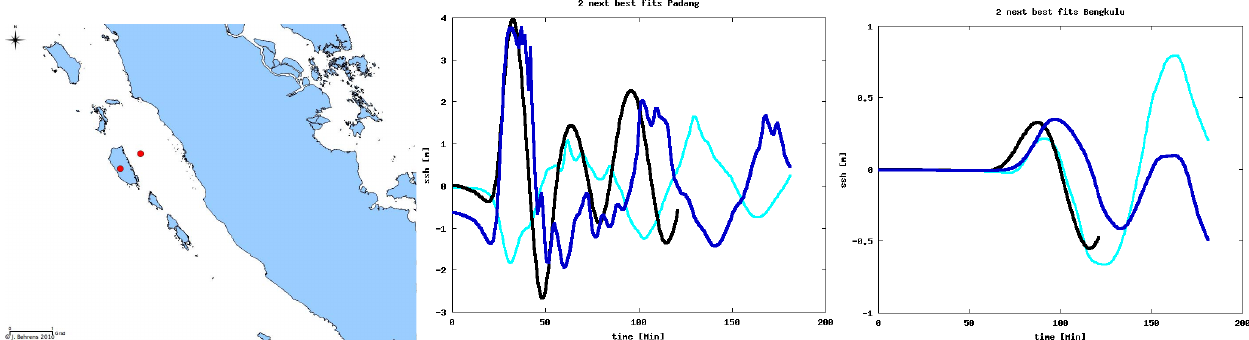
Fig. 13. Benchmark experiment with given seismic parameters, wave arrival at buoys, and GPS dislocation vectors (see Fig. 9 for description of the three panels). Table 3. Stages in the evaluation of the Padang earthquake. Data set Timestamp Time after rupture